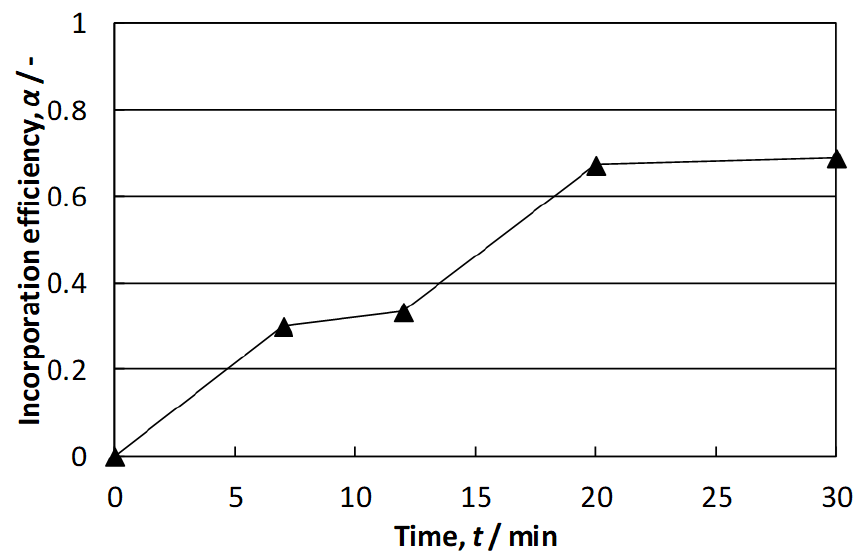
Figure 7. Time variation of incorporation efficiency (Powder B).